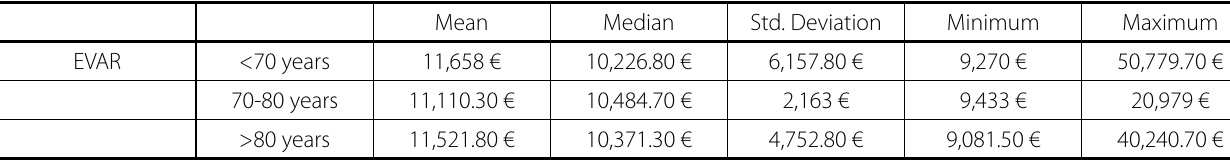
Table 7. Mean operative costs for patients undergoing